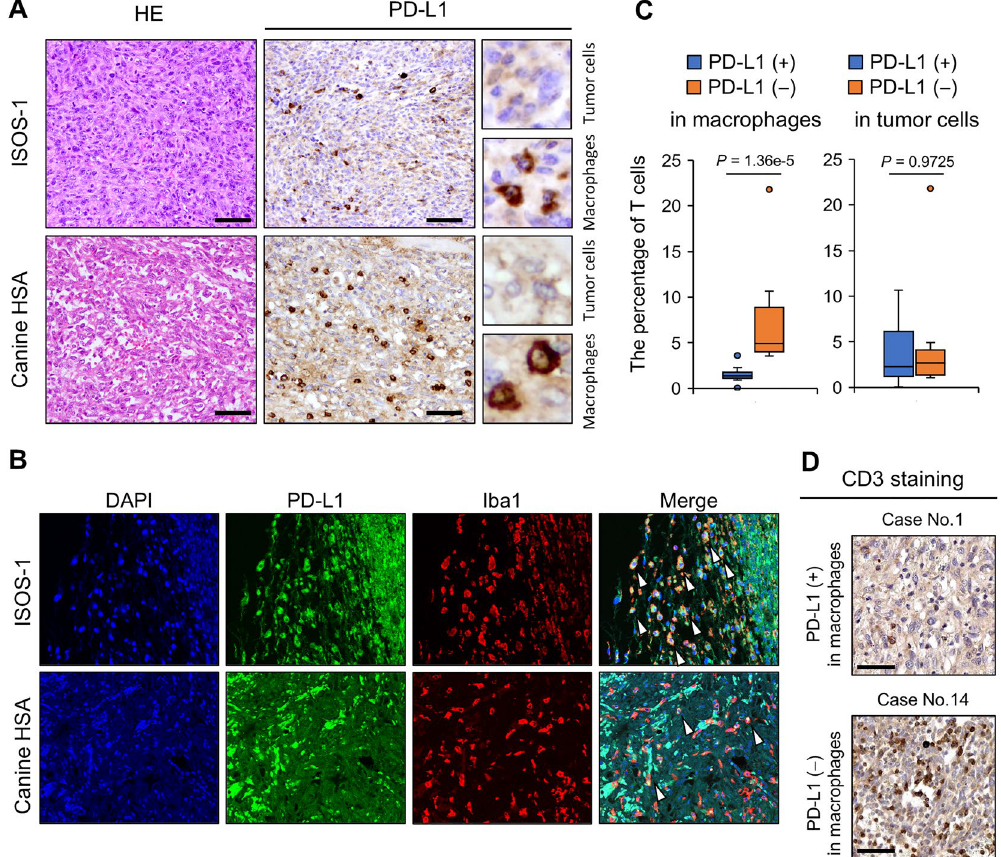
Figure 3. HSA tumor cells and tumor infiltrating macrophages express PD-L1. ( A ) HE staining and immunohistochemistry of PD-L1 for ISOS-1 and canine HSA tumors. HE staining images are the same as